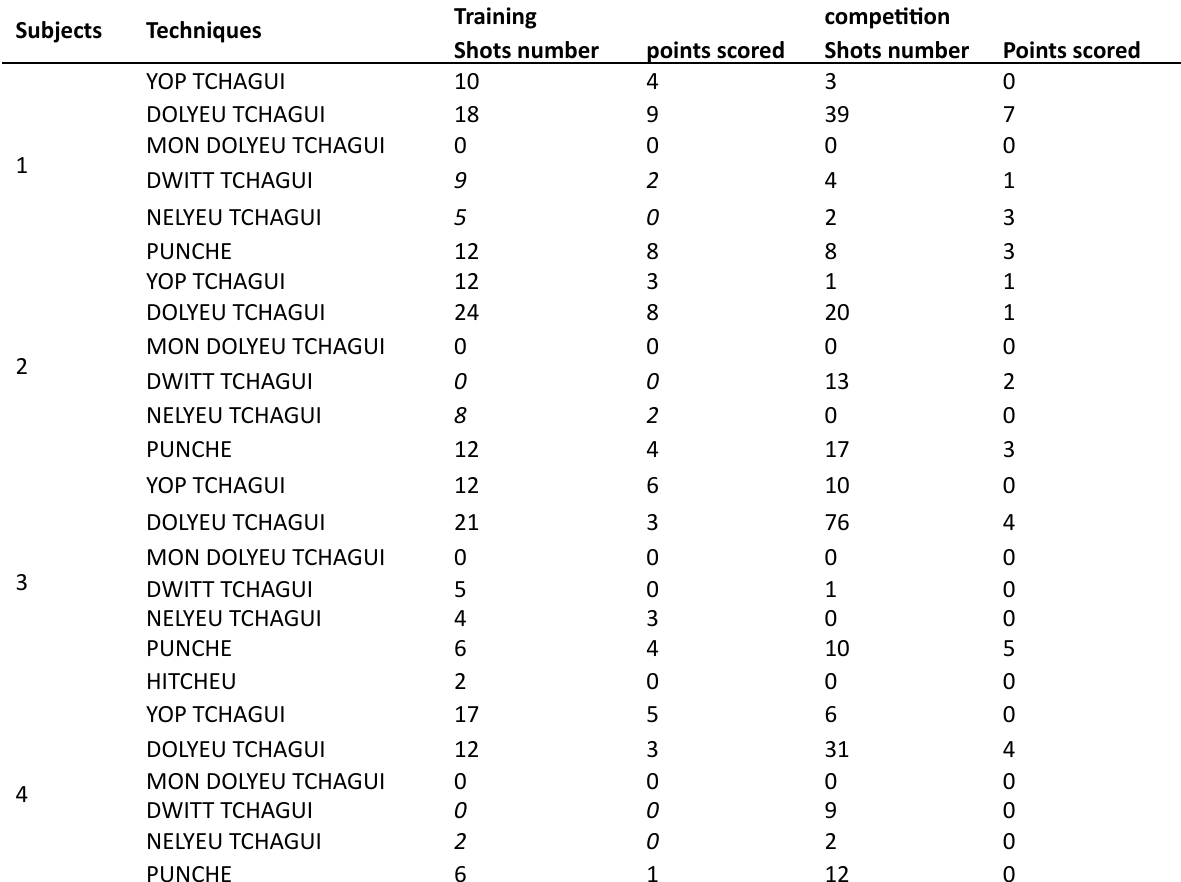
Table 8. Analysis of techniques used during training combat and those used in competitive combat: Subjects